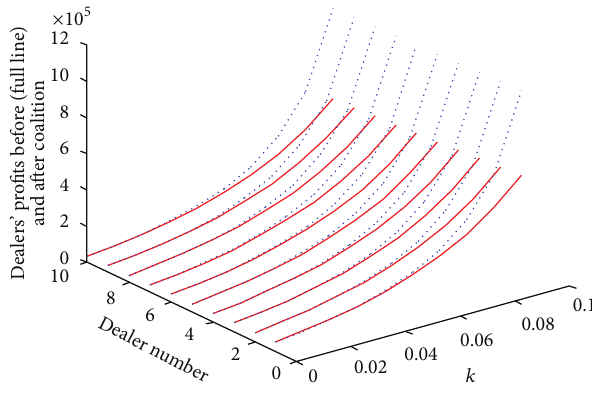
Figure 3: Dealers’ profits with and without coalition ( 𝑇 = 2